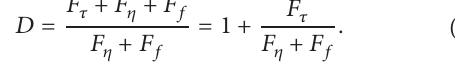
magnetic coils are needed to produce large magnetic fields. field produced and the power required by the magnetic